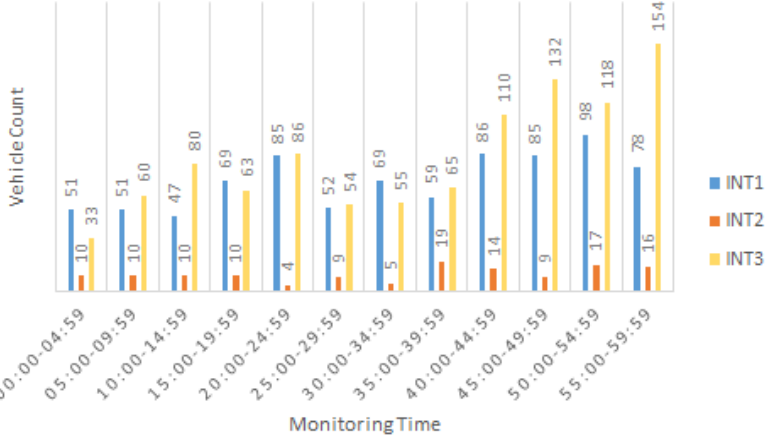
Figure 6. Branch-left (BL) count estimation in 5-min intervals.